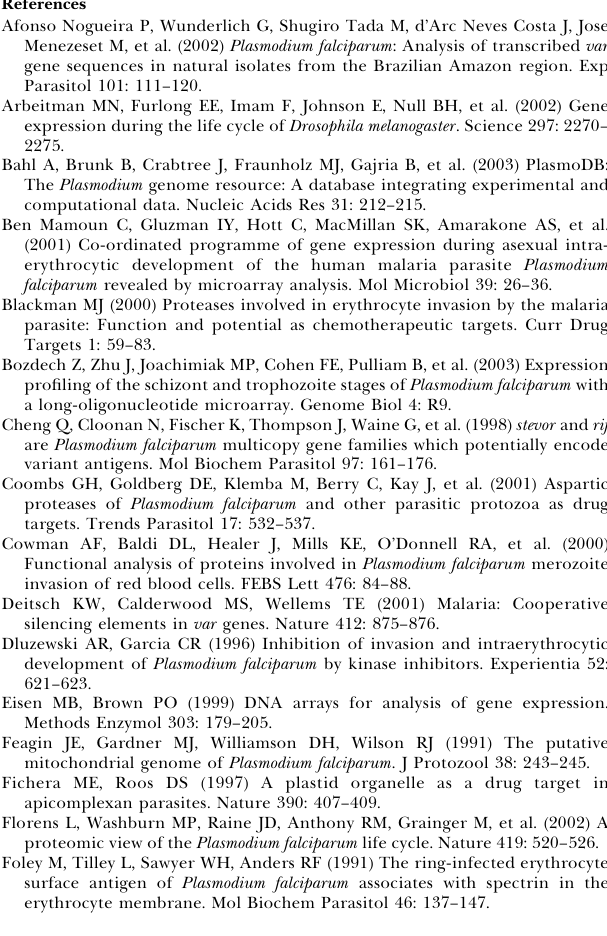
Table S4. 3D7 versus HB3 CGH Data